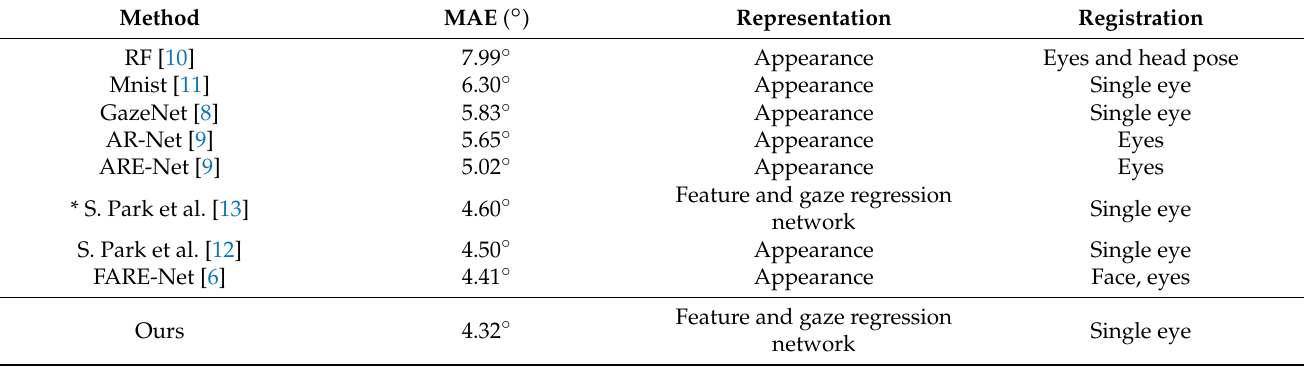
Table 5. Comparing the MAE, representation, and registration of several methods evaluated using MPIIGaze. (*: baseline